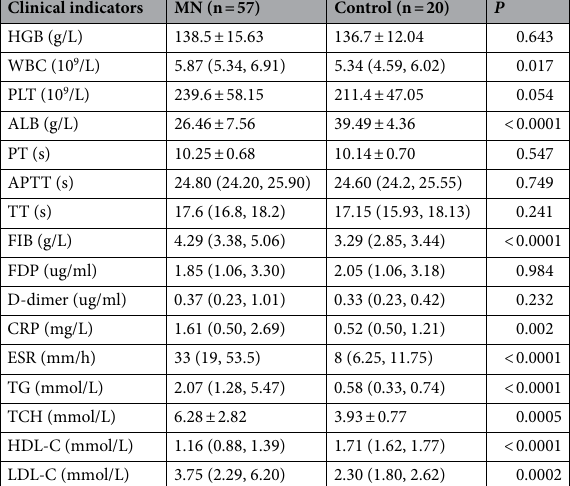
Table 2. Comparison of clinical indicators in MN and